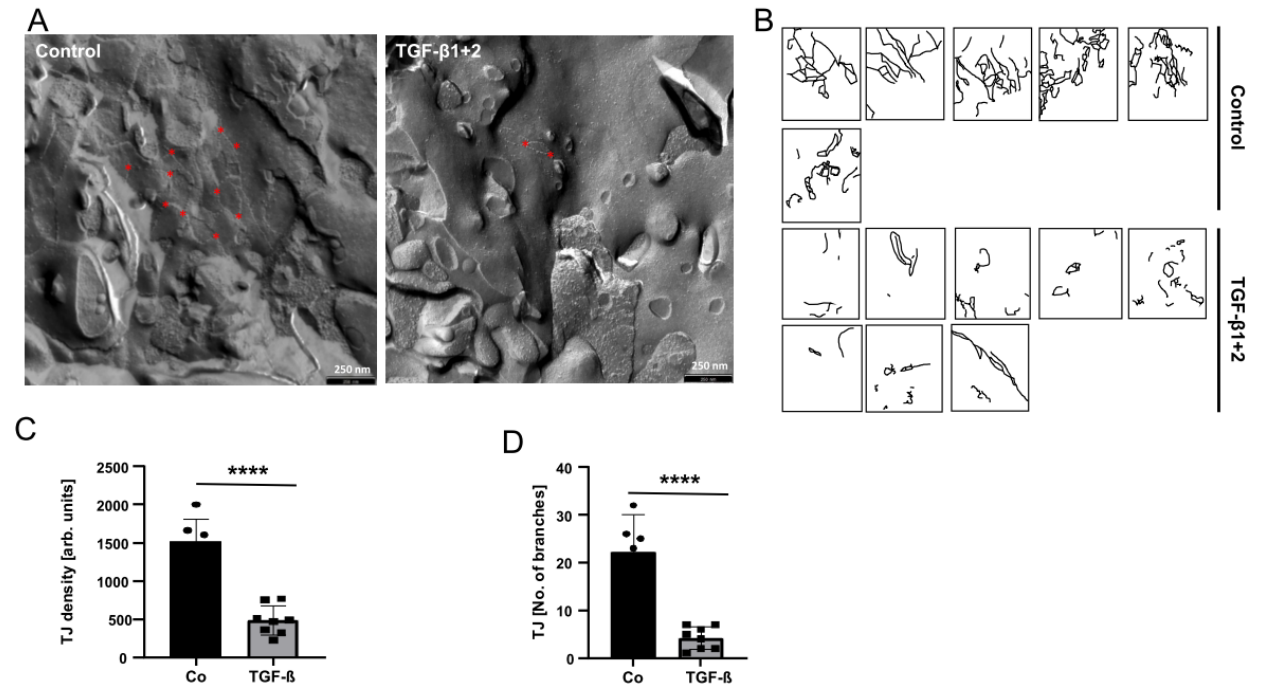
Figure 3. TGF- β treatment of HBVP reduced the amount and complexity of TJ in endothelial cells. ( A ) TGF- β 1 plus - β 2 (each 10 ng/mL) were added into the bottom chamber of wells containing intact BBB layers. Twenty-four hours later, PBMVEC growing on the upper part of the membrane were collected and prepared for freeze fraction electron microscopy. Red stars exemplarily indicate TJ branches. Exemplarily, one photograph is shown. ( B ) TJs were manually labeled in different visual fields ( n = 2, in total 4 replicates). ( C , D ) Quantification of TJs density ( C ) and complexity ( D ). Black bar and circles present controls, grey bars and squares present the TGF- β treatment ( n = 6 visual fields for controls, n = 8 for TGF- β ; **** p < 0.0001).